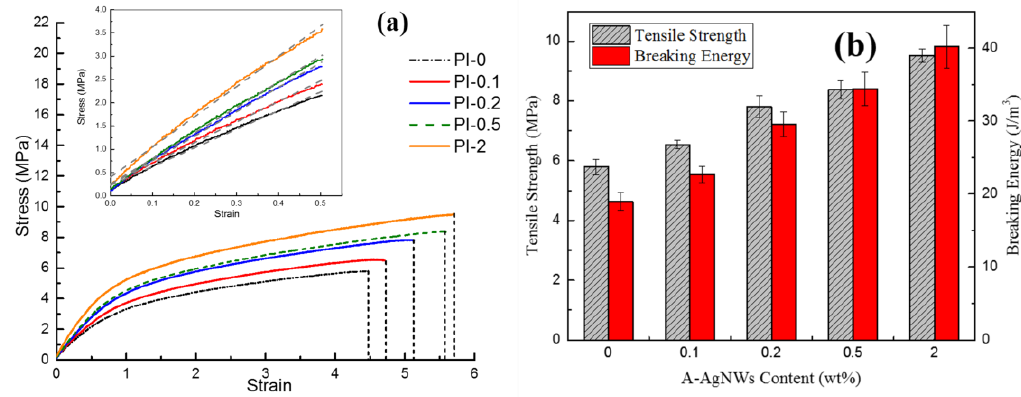
Figure 8. Results of tensile tests ( a ) stress–strain curves of PI-0 to PI-2; ( b ) statistics of tensile strength and breaking energy of PI-0 to PI-2.